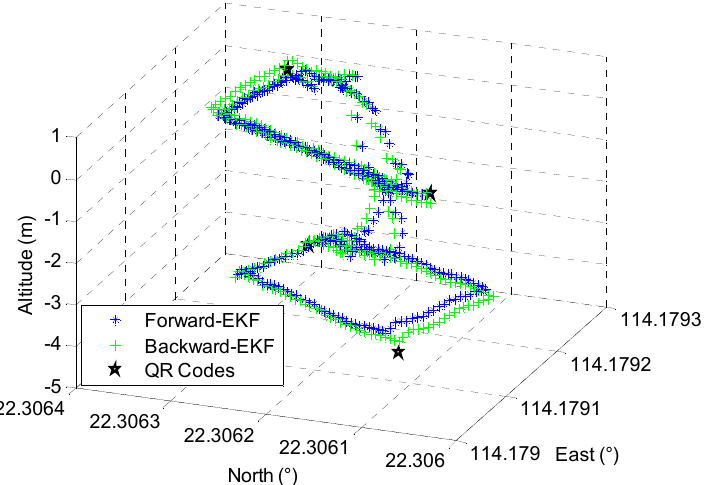
Figure 5. Comparison of Forward and Backward EKF.